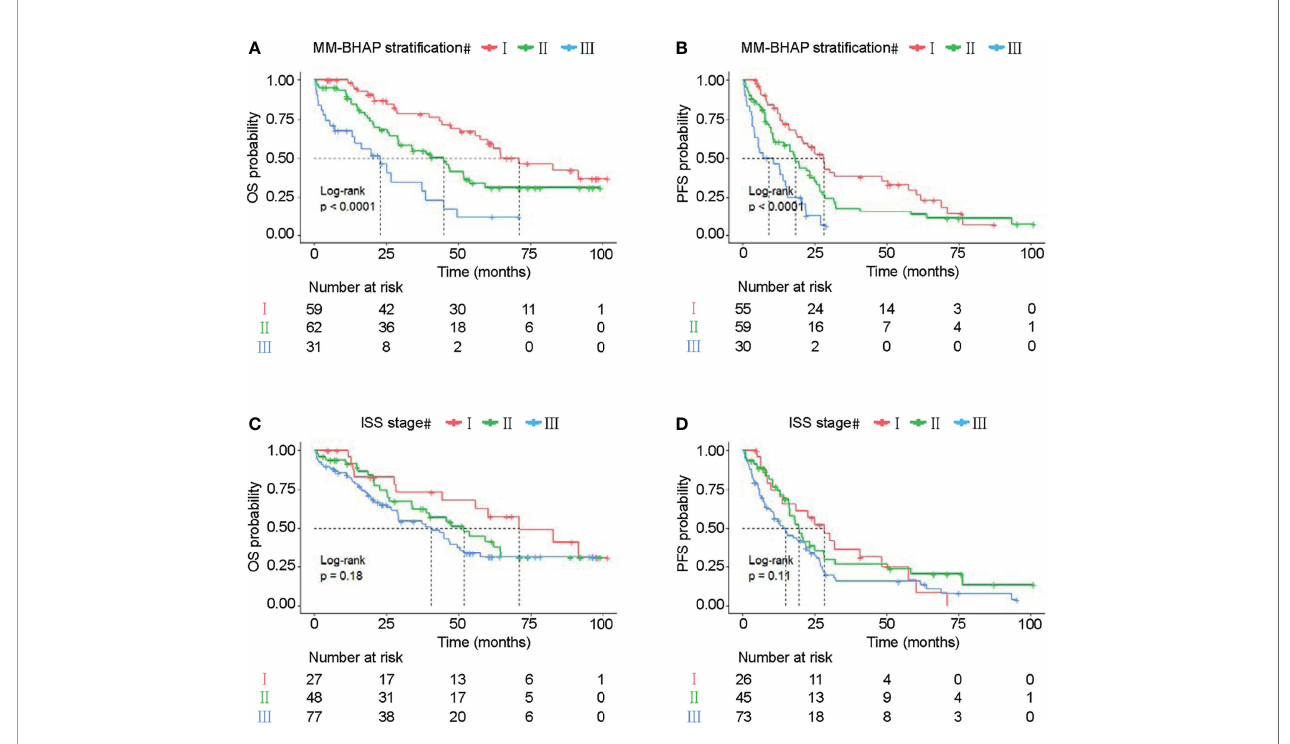
FIGURE 7 | The OS and PFS curves in the validation cohort strati fi ed by the MM-BHAP strati fi cation (A, B) and ISS stage (C, D)